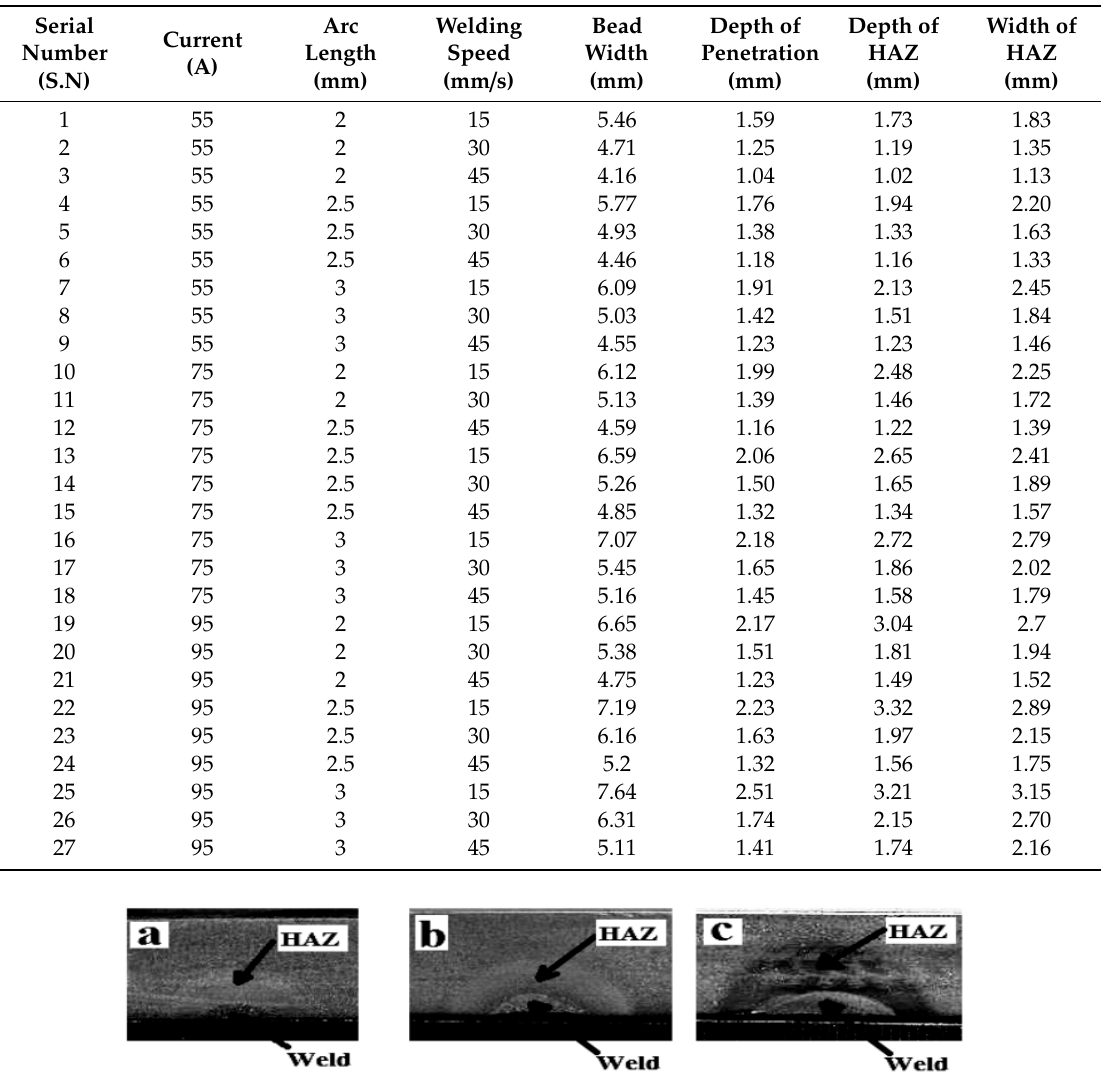
Figure 9. TIG welds polished and etched showing the weldments and HAZ with different process parameters. Current, arc length and traverse speeds are: ( a ) 55 A, 2 mm, 15 mm/s; ( b ) 75 A, 2.5 mm 30 mm/s; and ( c ) 95 A, 3 mm, 45 mm/s, respectively [20]. Table 7. Test data for 27 test experiments of bead-on-plate welds.